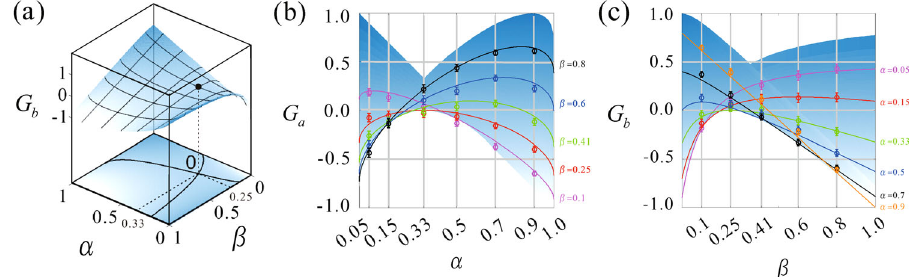
Fig. 1 Theoretical and experimental results of our protocol under R = 1 and γ = 8/9. a Bob ’ s average gain in a three dimensional view and contour view. The Nash-equilibrium is the point of G b = 0, β = 1/4 and α = 1/3. The lines in contour view show G b = 0. b Alice ’ s gain under her parameter α no matter which strategy Bob chooses. Lines and circles with different colors show the theoretical and experimental gain of Alice under different β , respectively. Her best choice is α = 1/3. c Bob ’ s gain under his parameter β no matter which strategy Alice chooses. Lines and circles with different colors show the theoretical and experimental gain of Bob under different α , respectively. The best strategy is choosing β =